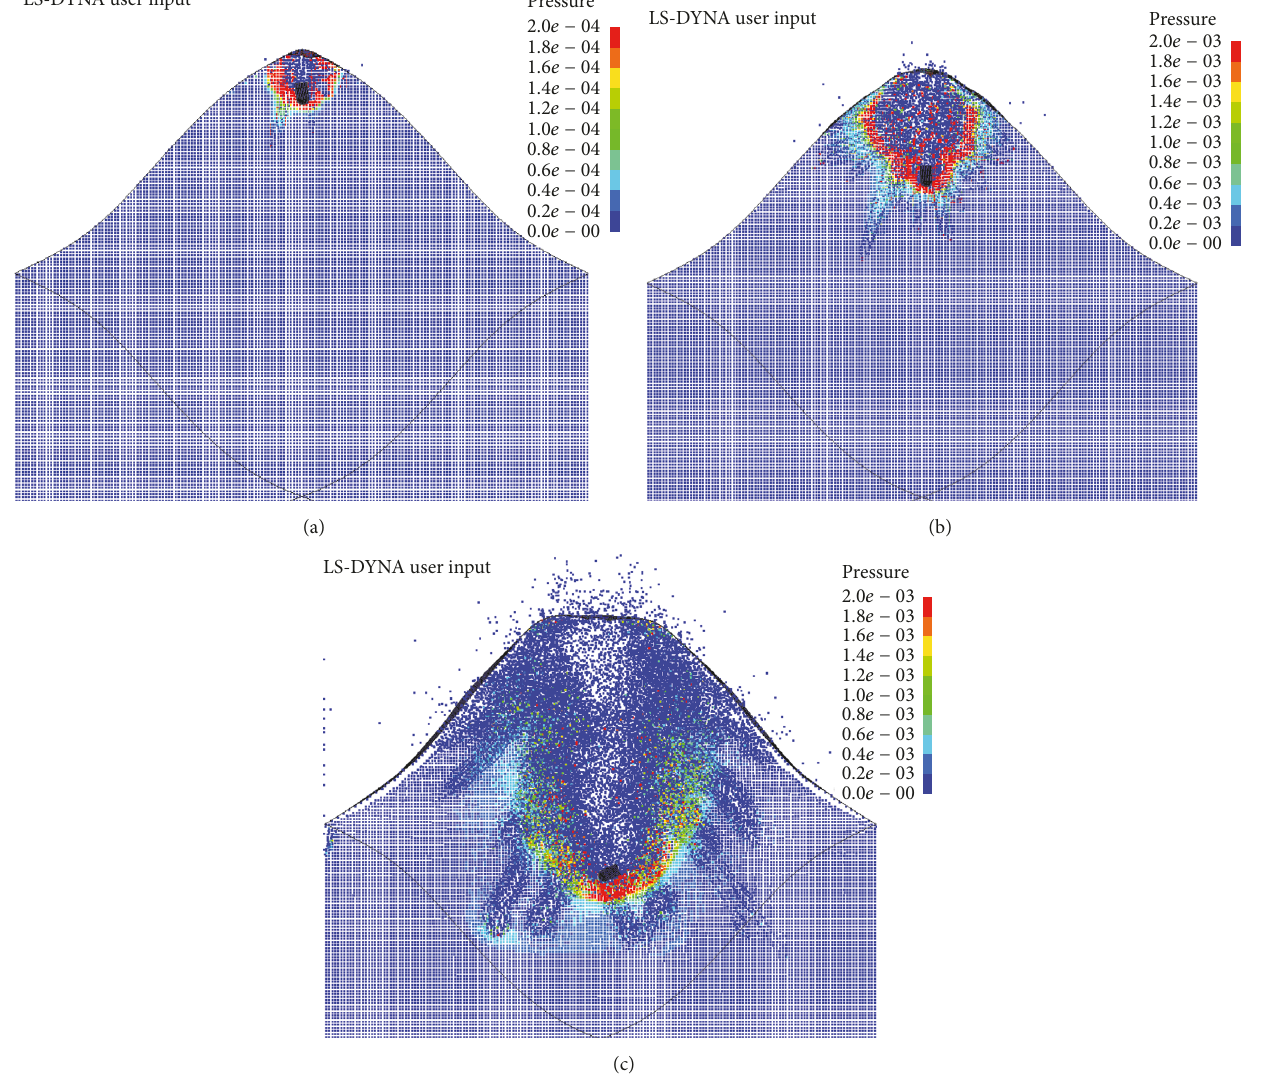
Figure 9: Pressure contour of penetration